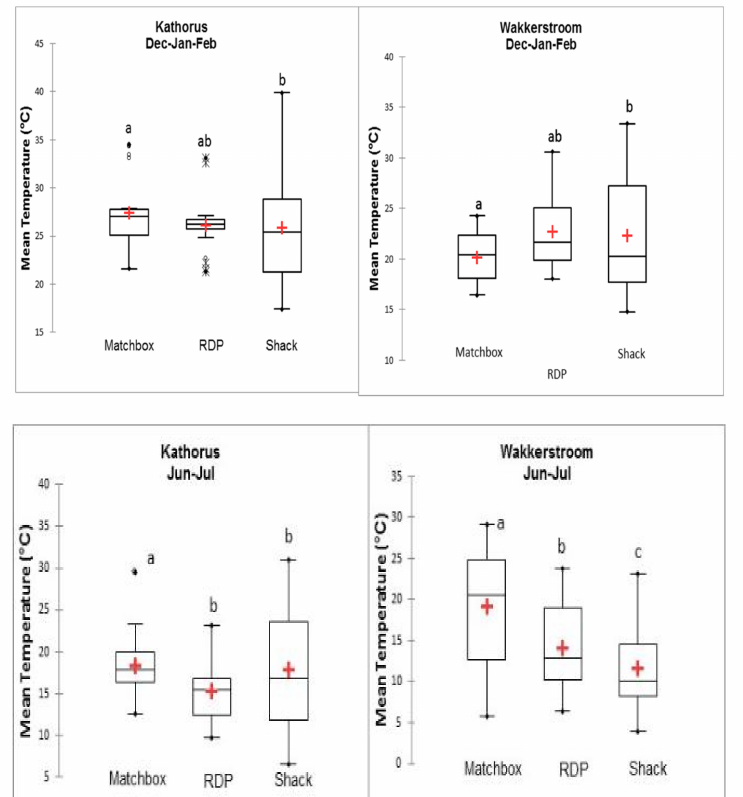
Figure 14. Boxplot comparing daily mean indoor temperature for all three housing types (n = 28) during both warmer and colder months in Kathorus and Wakkerstroom. The top whisker represents the highest value not including outliers; the upper quartile represents that 25% of the data are greater than this value. The middle (median) represents that 50% of the data are greater than this value; the bottom whisker represents that 25% of the data are less than this value; the bottom whisker is the minimum value also without